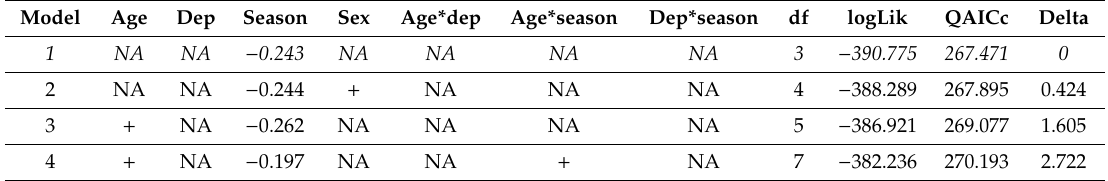
Table A2. QAICc of the four best models tested using the dredge function regarding VNT (i.e., lowest QAICc in a delta of two). The more parsimonious model is model 1 ( in italics ) that was finally retained.